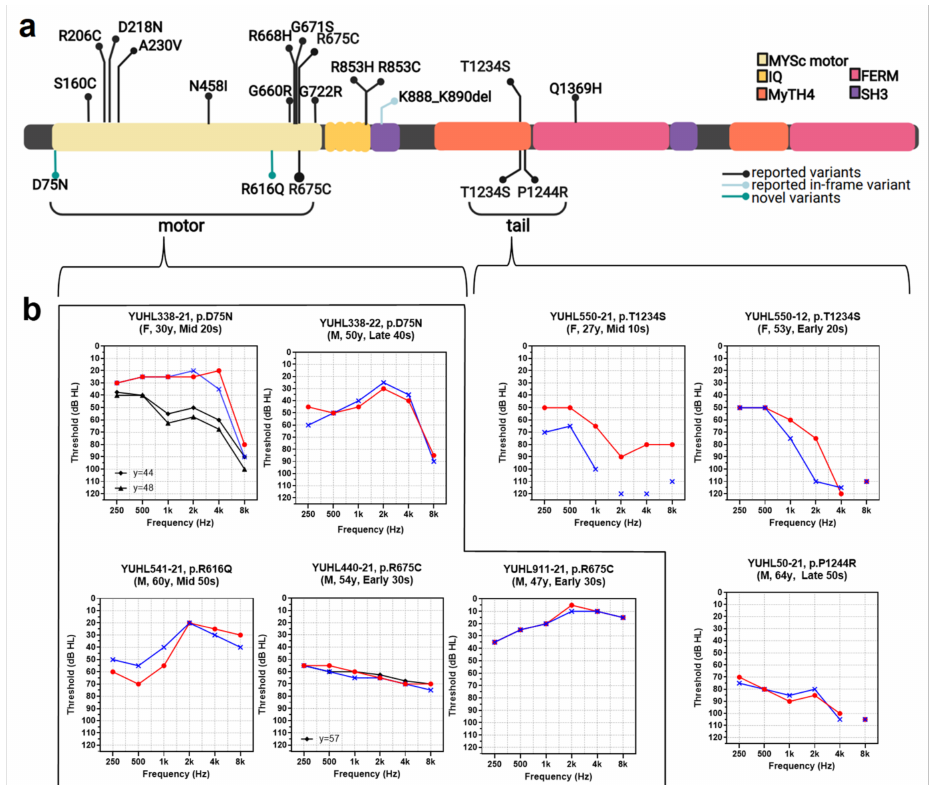
Figure 2. Variants of MYO7A identified in this study and audiogram of individuals diagnosed with DFNA11. ( a ) 15 DFNA11 variants previously reported (upper side of MYO7A functional regions) and five variants identified in this study (lower side). Among 18 variants of MYO7A, 12 were located at the motor region (MYSc; head domain) and three (p.R853H, p.R853C and p.K888_K890del) in the neck region. Including two other variants identified in this study, three variants were located at tail region, two (p.T1234S and p.P1244R) at MyTH4 domain, and one at FERM domain. ( b ) Onset-informed audiograms of probands of all DNFA11 families in YUHL cohort. All the unrelated DFNA11 families show phenotypic diversity of MYO7A variants. However, degree of hearing loss is clinically different; patients with variants at motor regions show mild to moderate hearing loss. Individuals with tail region variants show severe hearing loss. Red indicates right side PTA threshold of patients, while line in blue means PTA on the left